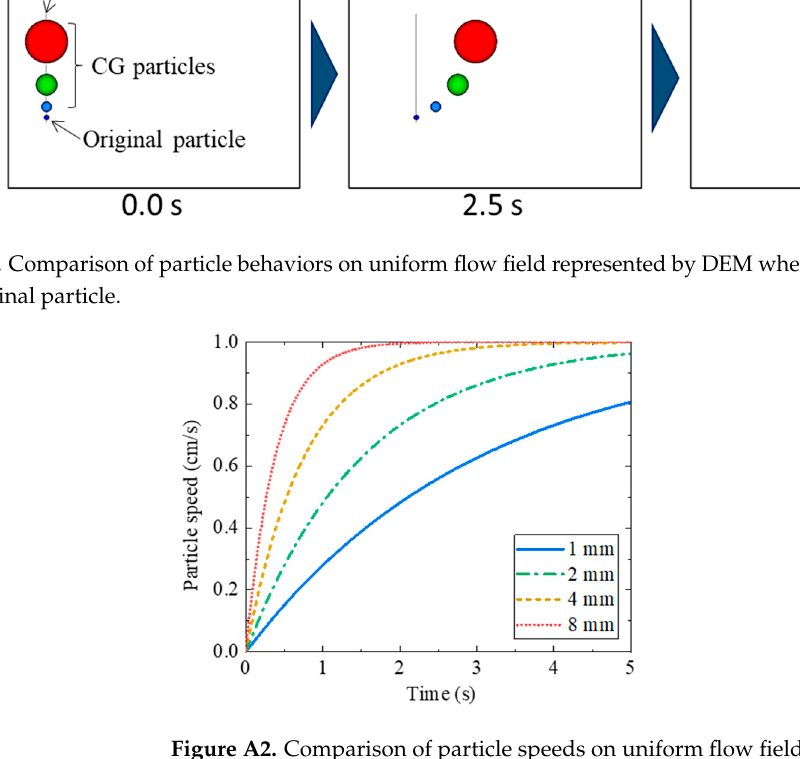
Figure A2. Comparison of particle speeds on uniform flow field represented by DEM when the CG particle masses equal to the original particle.